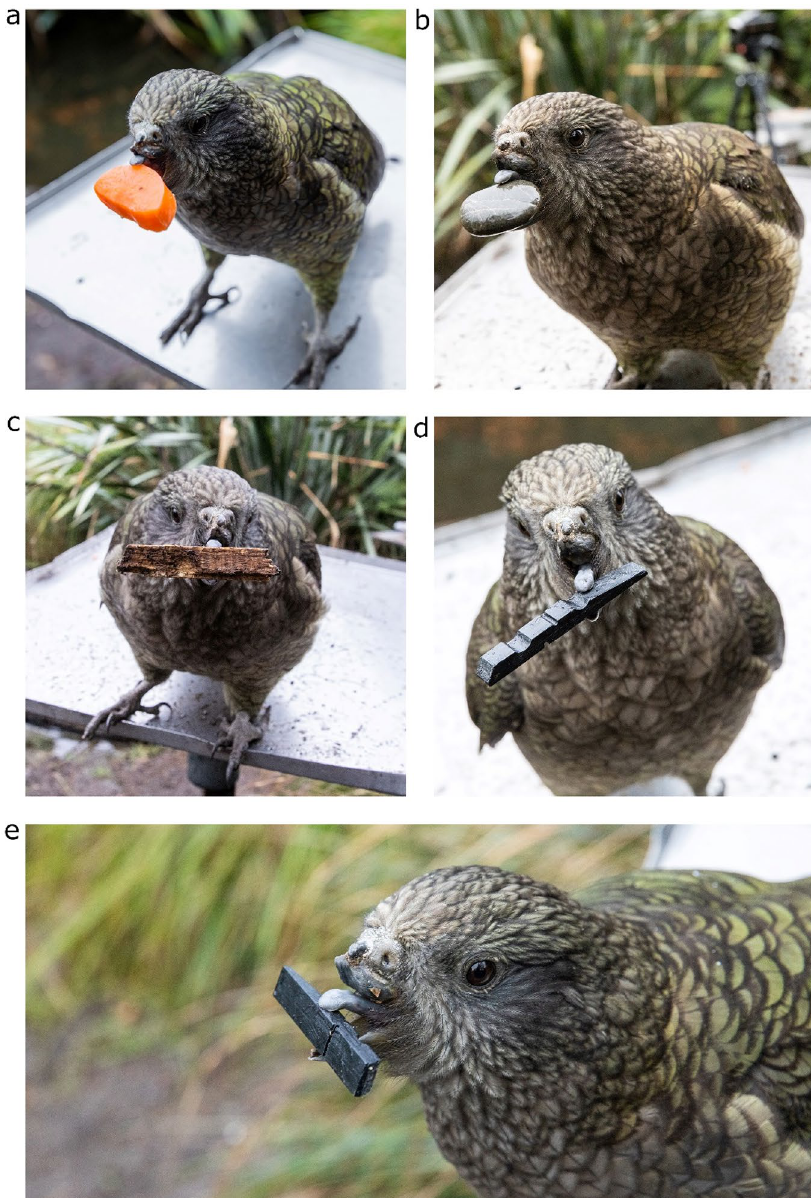
Figure 4. Photographs of Bruce handling objects larger than his preening pebbles, namely: ( a ) a slice of carrot, ( b ) a stone, ( c ) a piece of bark, ( d ) a black token used in previous cognitive experiments he was a part of. We also provide a close-up image in ( e ) demonstrating how he uses his tongue and lower mandible to hold these